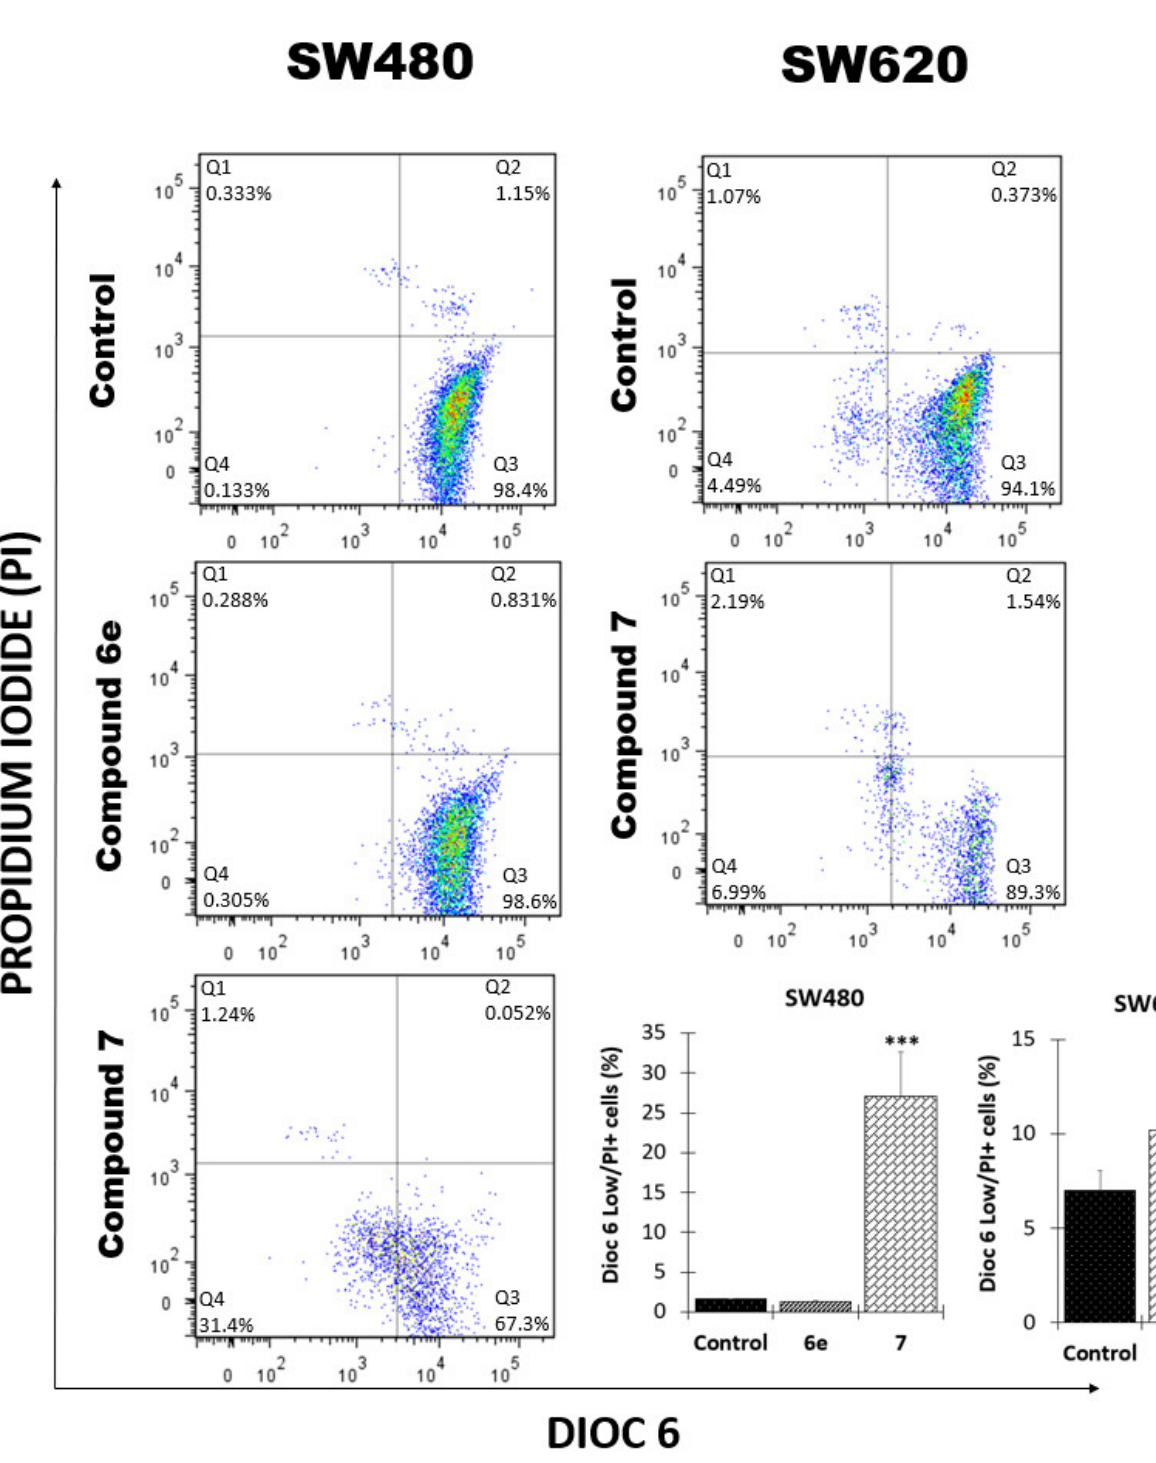
Figure 5. Mitochondrial membrane potential (ΔΨm) in SW480 and SW620 cells treated with either hybrids 6e , 7 , or DMSO 1% (vehicle control). Q1 and Q2: PI-positive cells with membrane damage. Q3: DiOC6 high, live cells with high membrane polarization; Q4: DiOC6 low, cells in latency that lose membrane polarization. *** p < 0.001 .